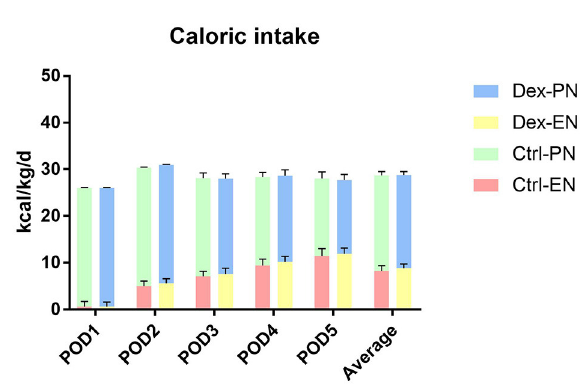
FIGURE1 Postoperative nutritional caloric intake. Dex-PN, dexamethasone group parenteral nutrition; Dex-EN, dexamethasone group enteral nutrition; Ctrl-PN, control group parenteral nutrition; Ctrl-EN, control group enteral